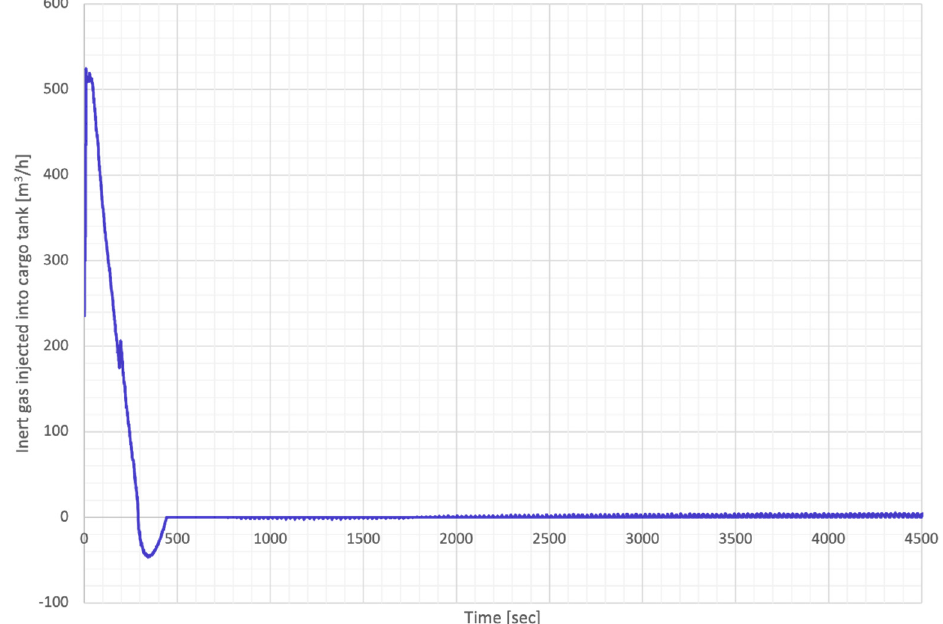
Figure 13. Inert gas flow rate injected into the cargo tanks.